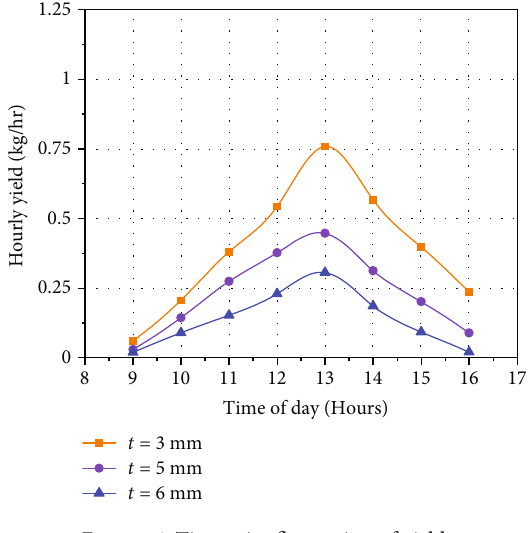
Figure 6: Time-wise fl uctuation of yield.